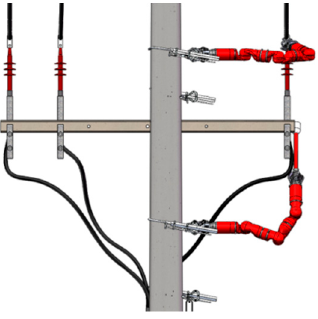
Figure 23. Double robots cooperate to replace the arrester.